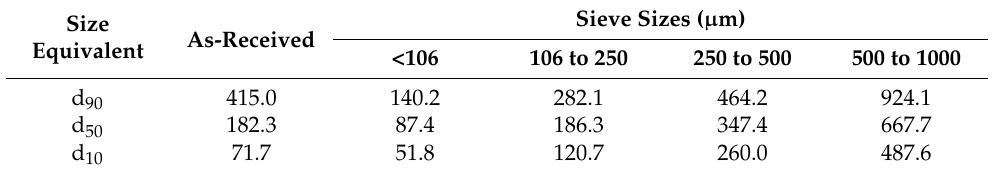
Table 2. D 90 , d 50, and d 10 ( µ m) of as-received and size fractioned chromite.